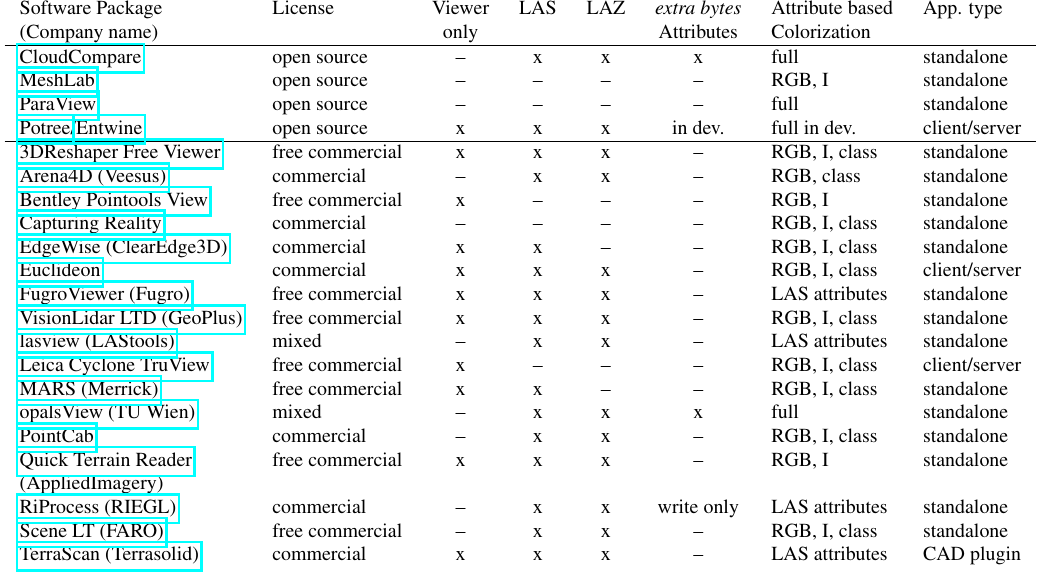
Table 1. List of open source and commercial point cloud software